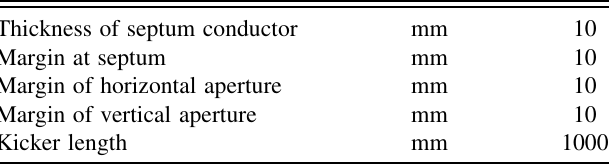
TABLE XIX. Geometrical constraint of kicker design; ‘‘mar- gin’’ means the space outside the beam excursion with the beam size of 10 (cid:8) mm mrad (unnormalized).